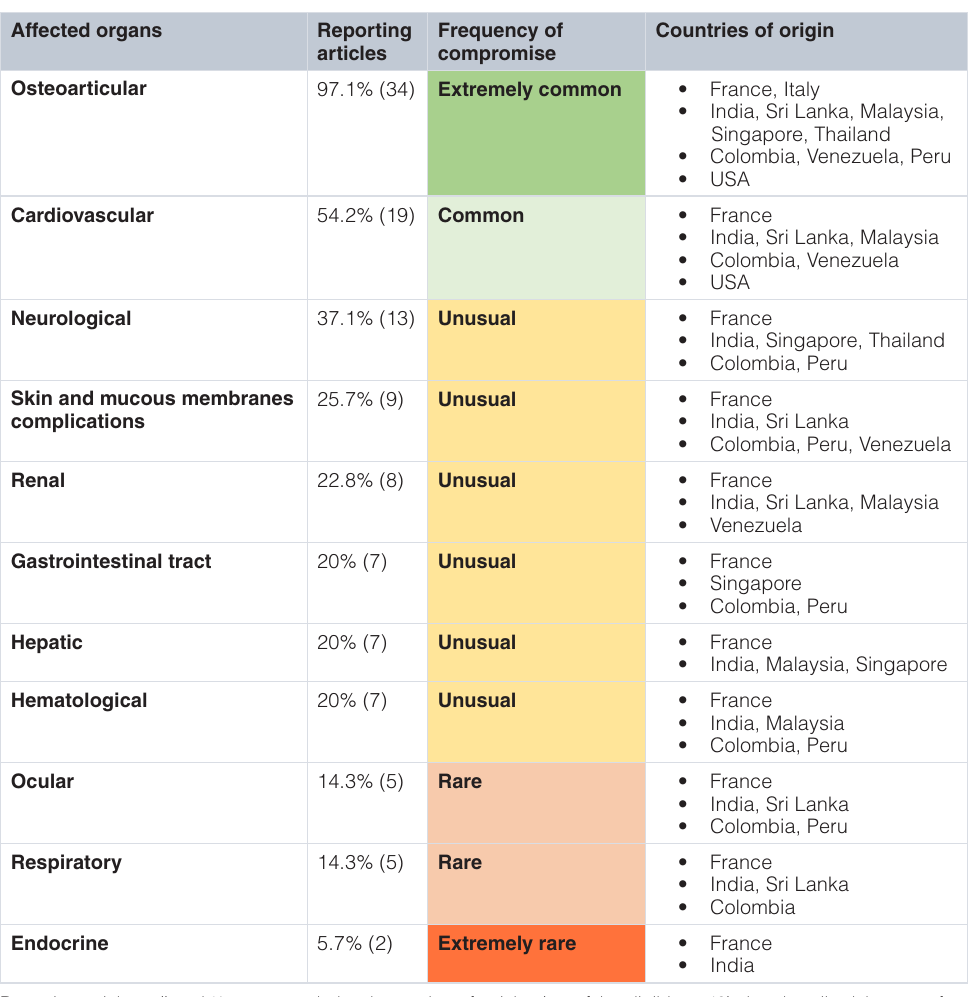
Table 1. Frequency at which different organ systems are affected during CHIKV